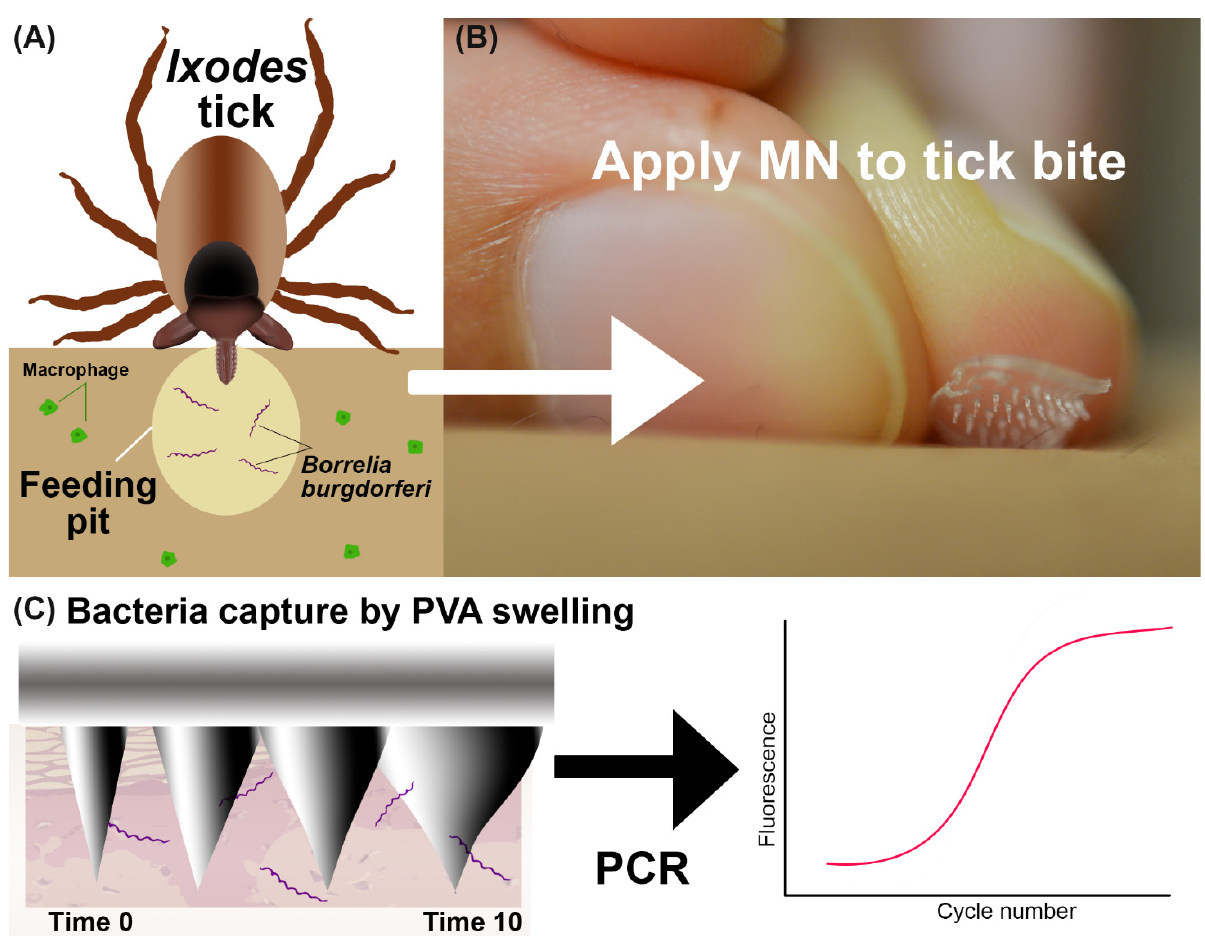
Figure 1. Overview of the bacteria detection method. ( A ) Graphic showing Ixodes tick feeding and inserting B. burgdorferi bacteria into skin. The tick saliva provides a feeding pit where bacteria are protected from immune cells. ( B ) A MN is placed onto the skin manually. ( C ) Illustration of MN capture of bacteria with swellable PVA and direct PCR detection.